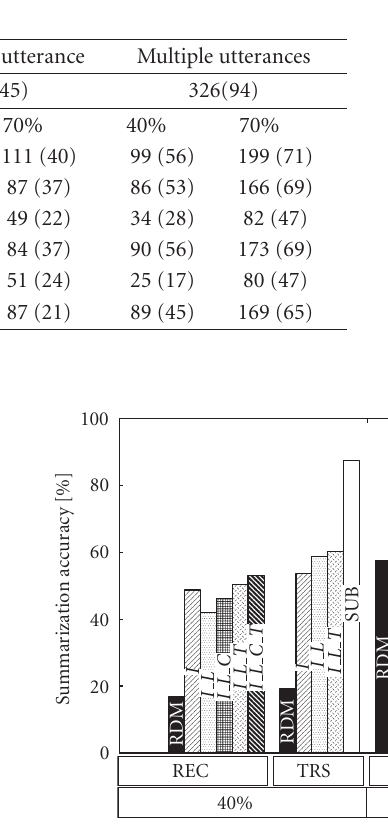
Table 2: Number of recognition errors in summarized sentences (( · ) is the number of sentences including recognition errors).